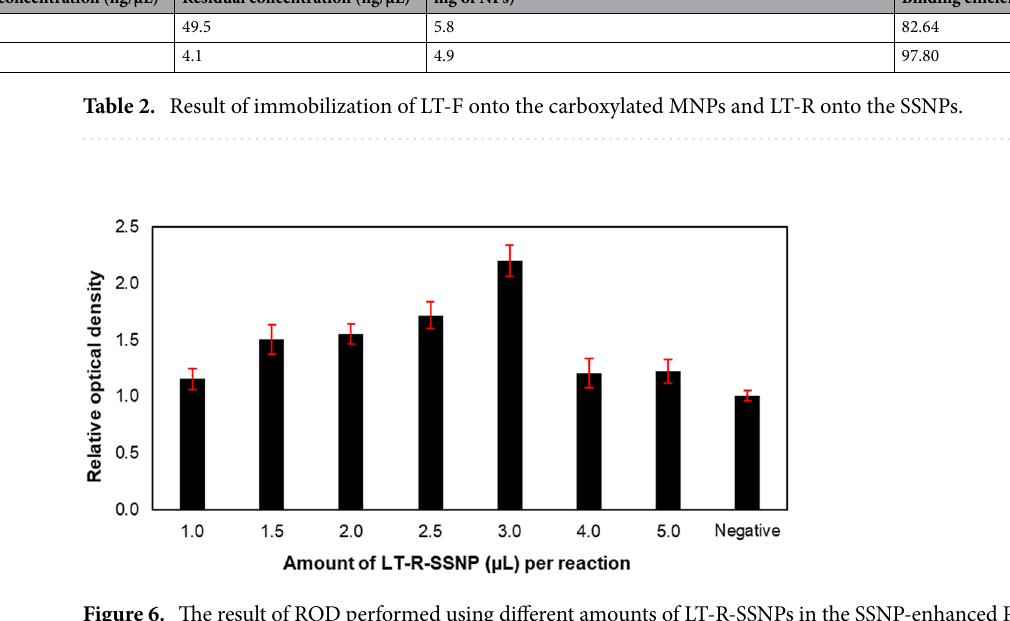
Figure 6. The result of ROD performed using different amounts of LT-R-SSNPs in the SSNP-enhanced PCR assay (Negative = DNA-free